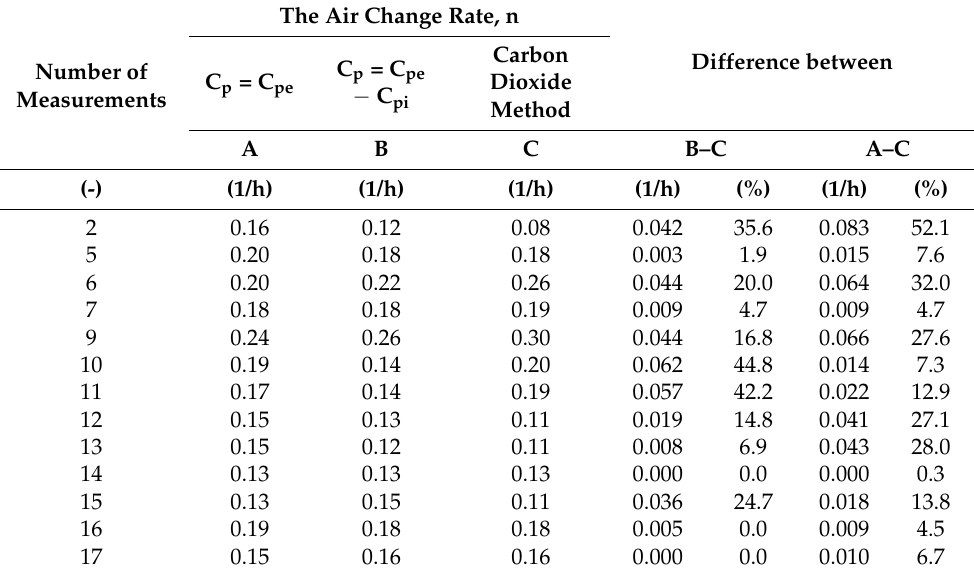
Figure 14. The difference between values of air change rate taking into account the influence of openings C p = C pe − C pi and the values based on experimental measurements of carbon dioxide for higher wind speed v = 4.4 m/s–10.3 m/s.